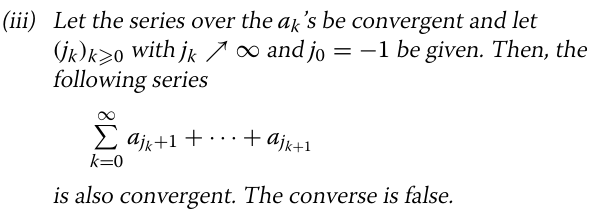
of 260 marks that the students could achieve on the 13 exercise sheets.